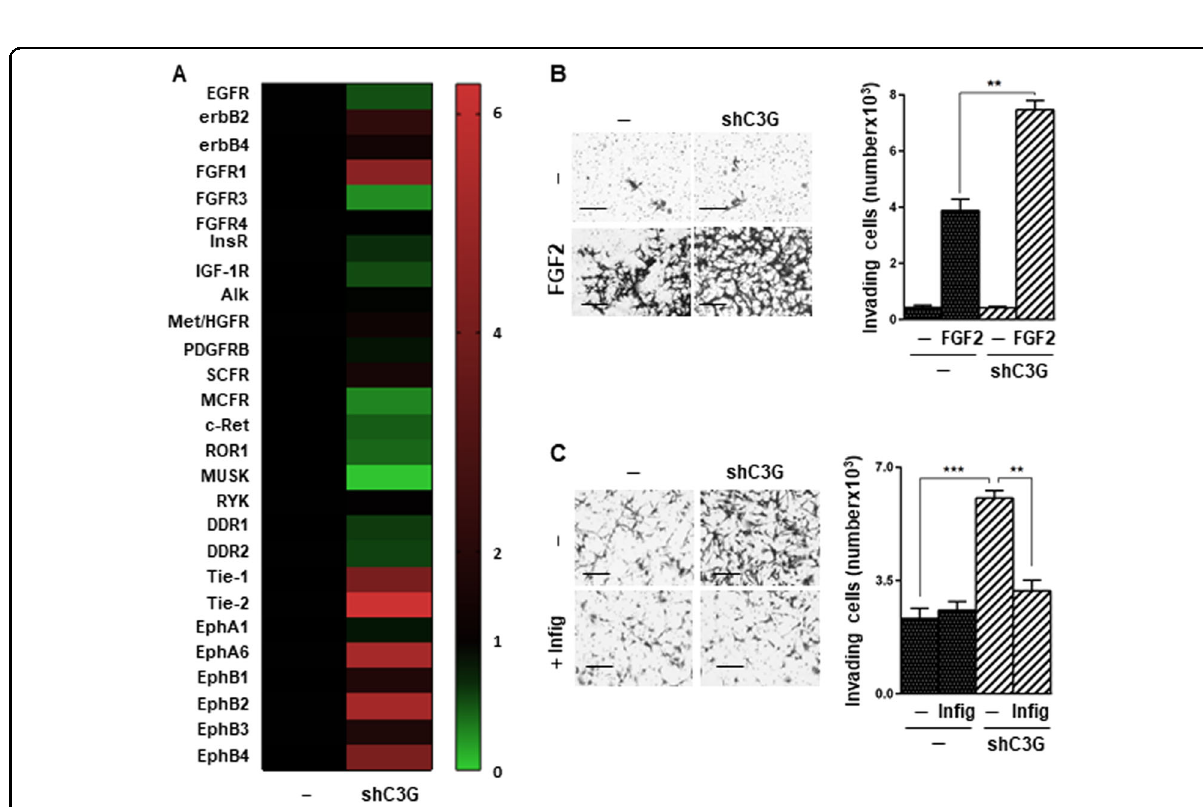
Fig. 6 C3G downregulation increases the phosphorylation of FGFR1 and other RTKs, promoting cell invasion. A Heatmap represents the relative phosphorylation levels of 27 RTKs present in the proteome pro fi ler human phospho-RTK array. For each receptor, the mean value of the densitometric quanti fi cation of C3G silenced cells values as compared to parental cells ( n = 2). B FGF2-induced invasion. Cells seeded in the upper chamber of transwells were maintained in the absence of serum and were treated with FGF2. Left panel, representative phase contrast microscopy images of invading cells; right panel, histogram showing the mean value ± S.E.M. of the total number of invading cells ( n = 3). * p ≤ 0.05 and ** p ≤ 0.01, compared as indicated. Scale bars: 100 µm. C Effect of in fi gratinib on invasion using serum (10%) as chemoattractant. Left panels, representative phase contrast microscopy images of invading cells; right panel, histogram showing the mean value ± S.E.M. of the total number of invading cells ( n = 3). ** p ≤ 0.01 and *** p ≤ 0.001, compared as indicated. Scale bars: 100